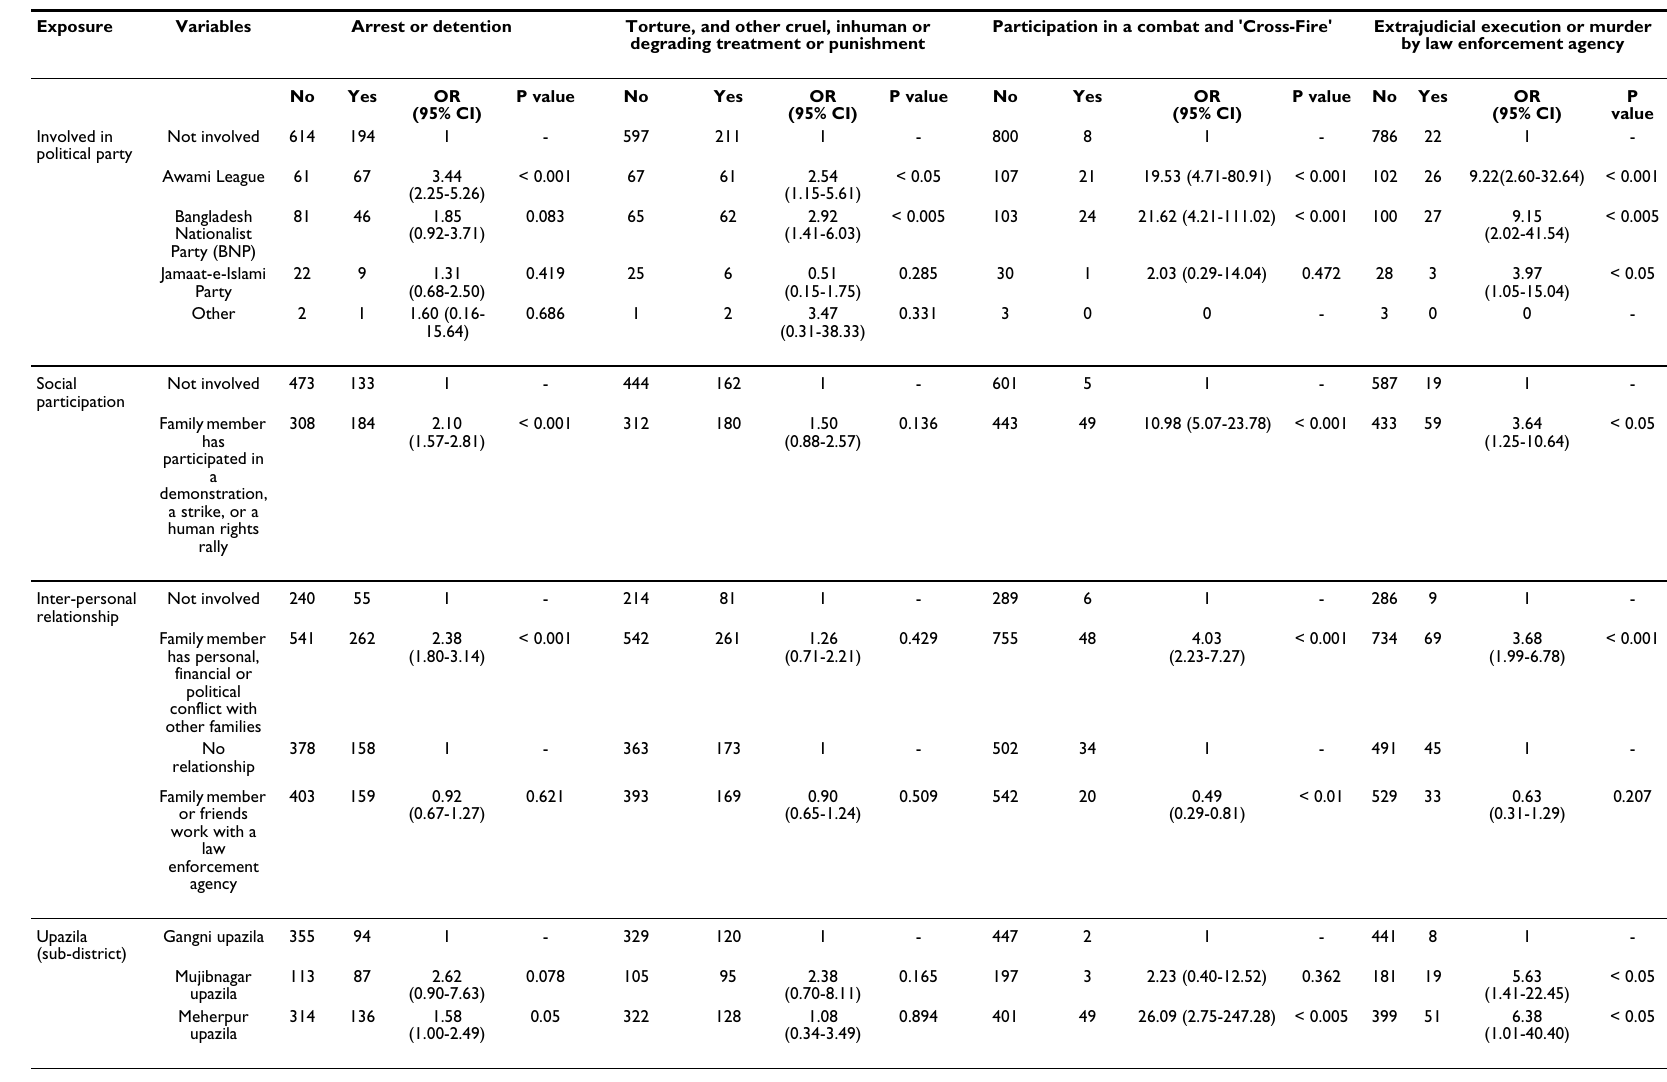
Table 4: Exposure variables of organised crime and political violence (OPV) and human rights violations Exposure Variables Arrest or detention Torture, and other cruel, inhuman or